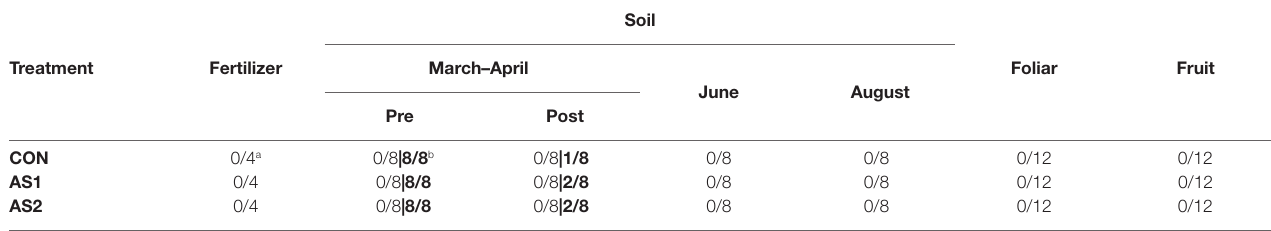
TABLE 4 | Detection of Salmonella in fertilizer, soil, foliar, and blueberry fruit samples in 2017–2018.